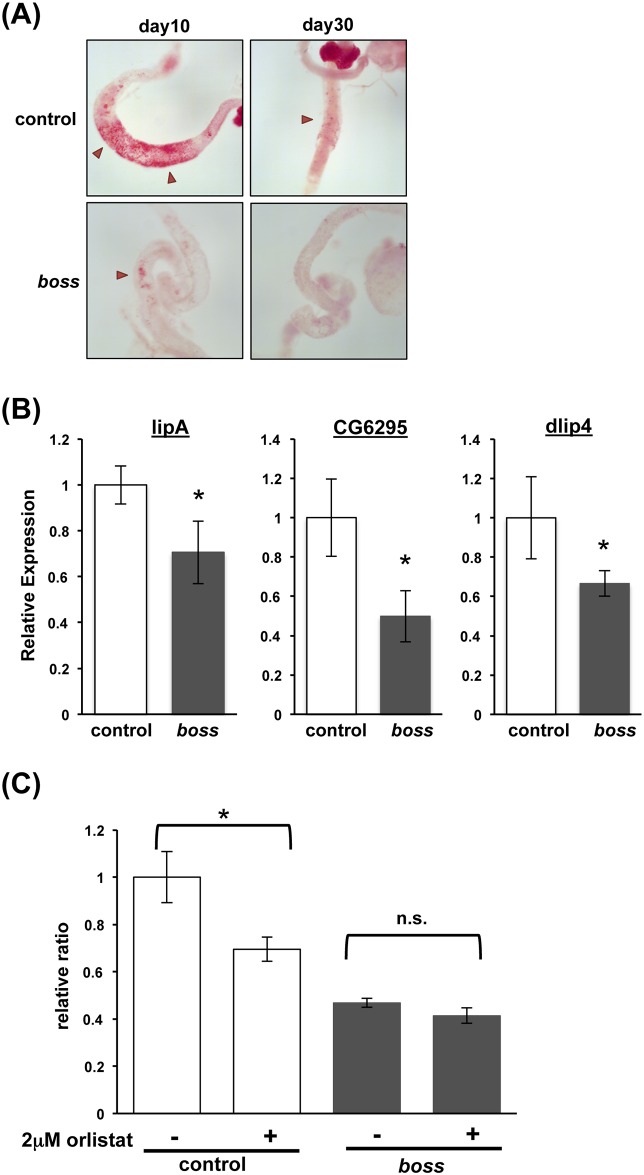
Gut lipase activity declines with aging in boss mutant flies.(A) Oil-Red-O staining of neutral lipids in the guts of young (10-days) and old (30-days) control and boss mutant female flies. Anterior midgut region stores lipid (arrowhead). (B) Expression of gut lipases (lipA/margo, CG6295, and dlip4) in the intestines of young (day 10) flies, as assessed by qRT-PCR (n = 3, 5 guts per replicate). (C) boss mutant flies are resistant to orlistat treatment. Young adult male boss mutant flies and control flies were fed a diet with or without orlistat (2.0 μM) for 5 days. Afterward TAG levels were determined (n = 5, 10 flies per replicate) and normalized for total protein. Levels are presented as normalized to levels for wild-type flies. Data are mean relative ratios ± SEM, and differences are significant by t-test (*P<0.05).